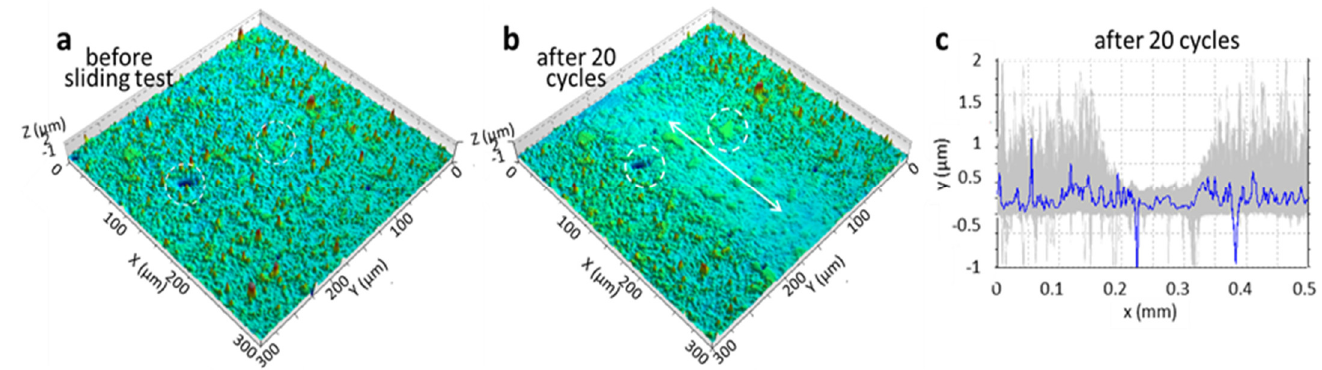
Figure 8. Three-dimensional profile images of the wear tracks on AIP TiN hard coating on D2 tool steel substrate before ( a ) and after 20 cycles of sliding against an alumina ball ( b ). The scanning area was 0.3 mm × 0.3 mm. Both 3D-profile images were taken from the same area on the substrate surface (the same sites before and after the test are labeled with the white circles). The sliding direction is indicated by arrows. The protrusions at sites of carbides are still visible in the wear track. The sharp peaks are the nodular defects, while the blue dots are craters (note the strong exaggeration in z-scale). ( c ) A series of a numerous line profiles were recorded perpendicular to the wear track and stacked together. The blue profile represents the level of coating, while grey peaks belong to protrusions.